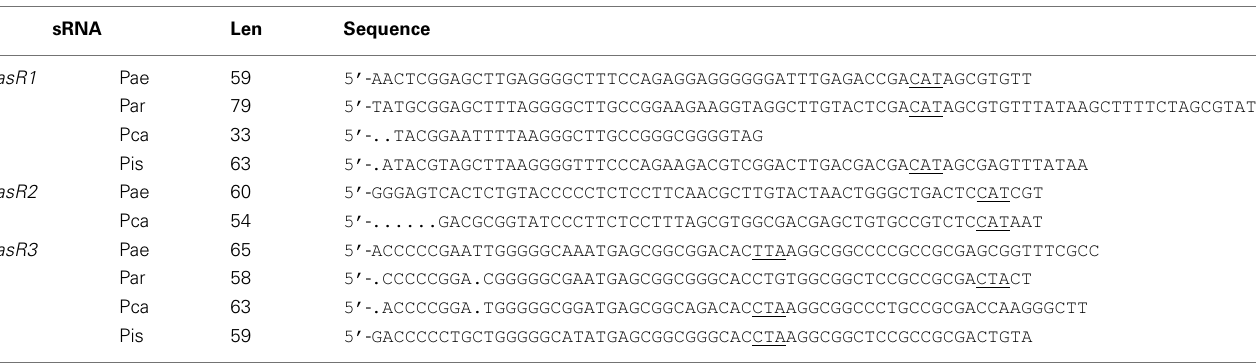
Table 2 |Terminal cis-antisense encoded sRNA in Pyrobaculum